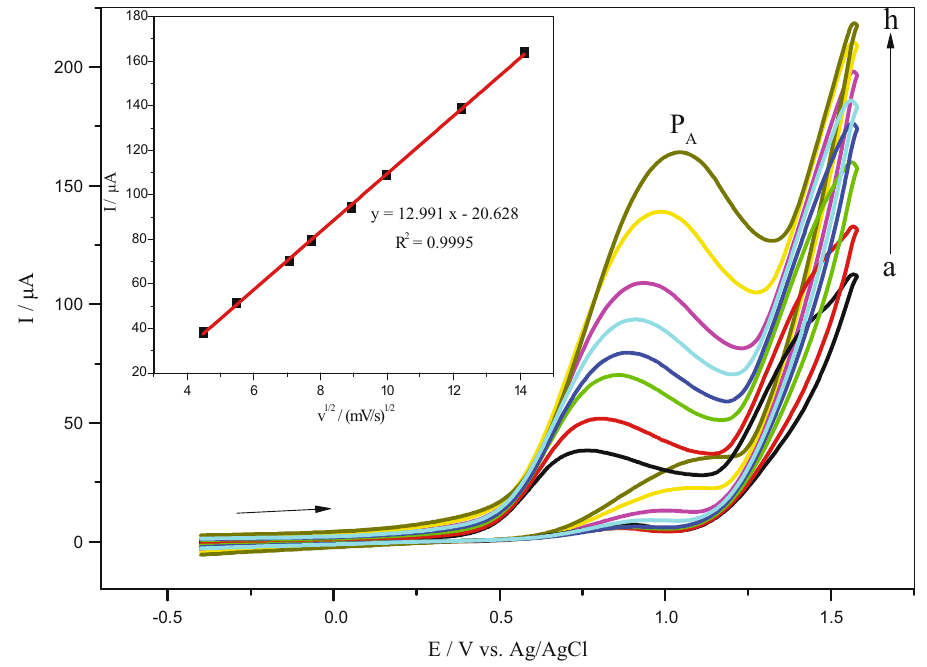
Figure 5: CVs of 0.5 mM NPX in 0.1 M PBS ( pH = 7.0 ) on poly ( r - o - NBA ) /GQDs/CPE at di ff erent scan rates from a to h ( 20, 30, 50, 60, 80, 100, 150, and 200 mV · s − 1 ) . Inset: the plot of I P versus ν 1/2